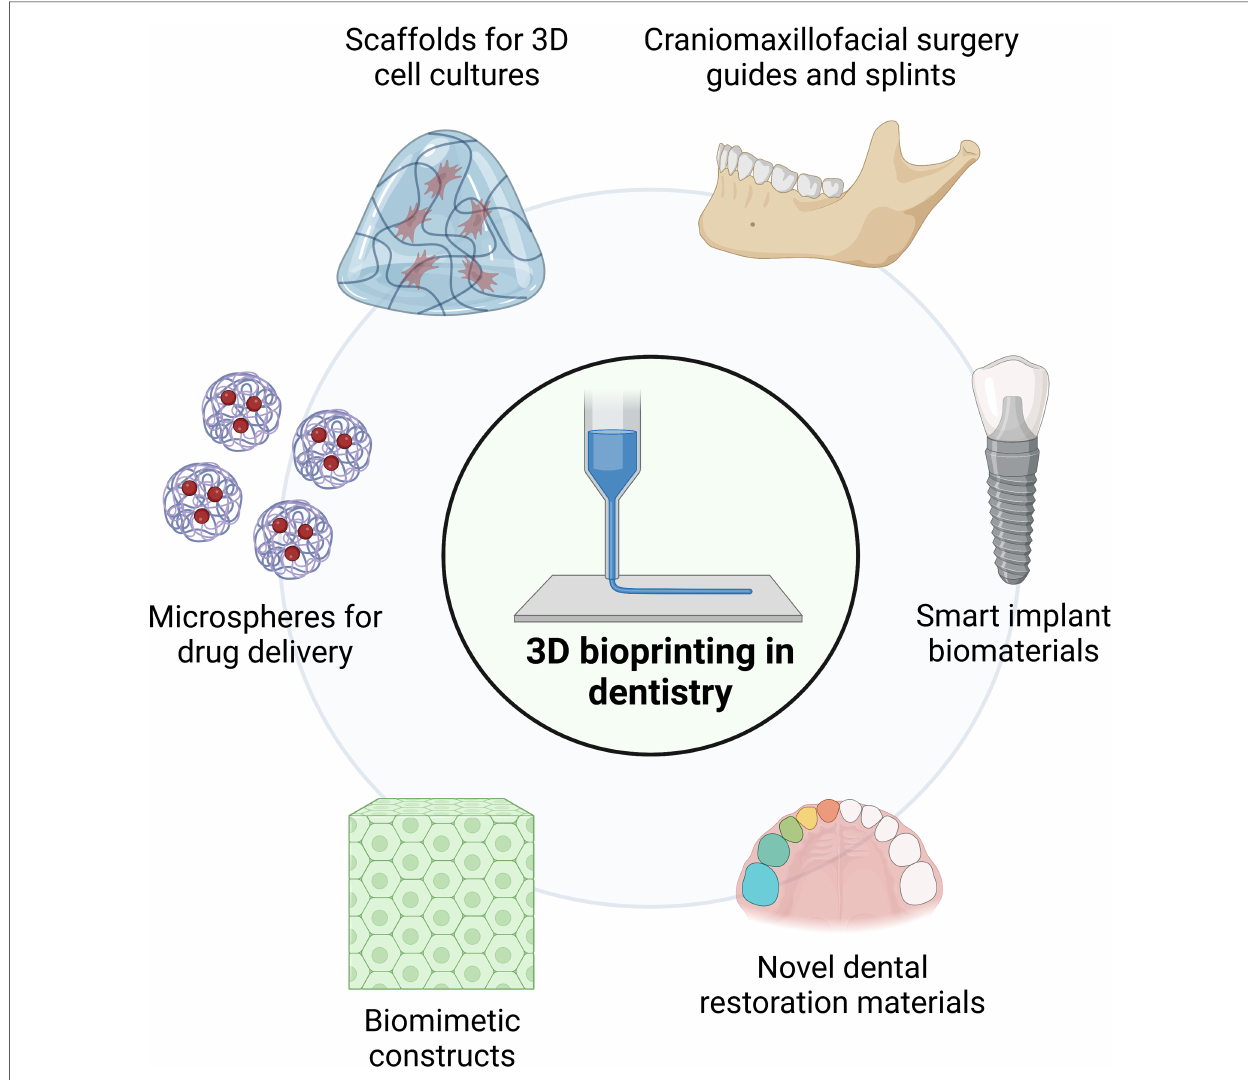
FIGURE 2 Current and potential clinical uses of microfabrication and 3D bioprinting in